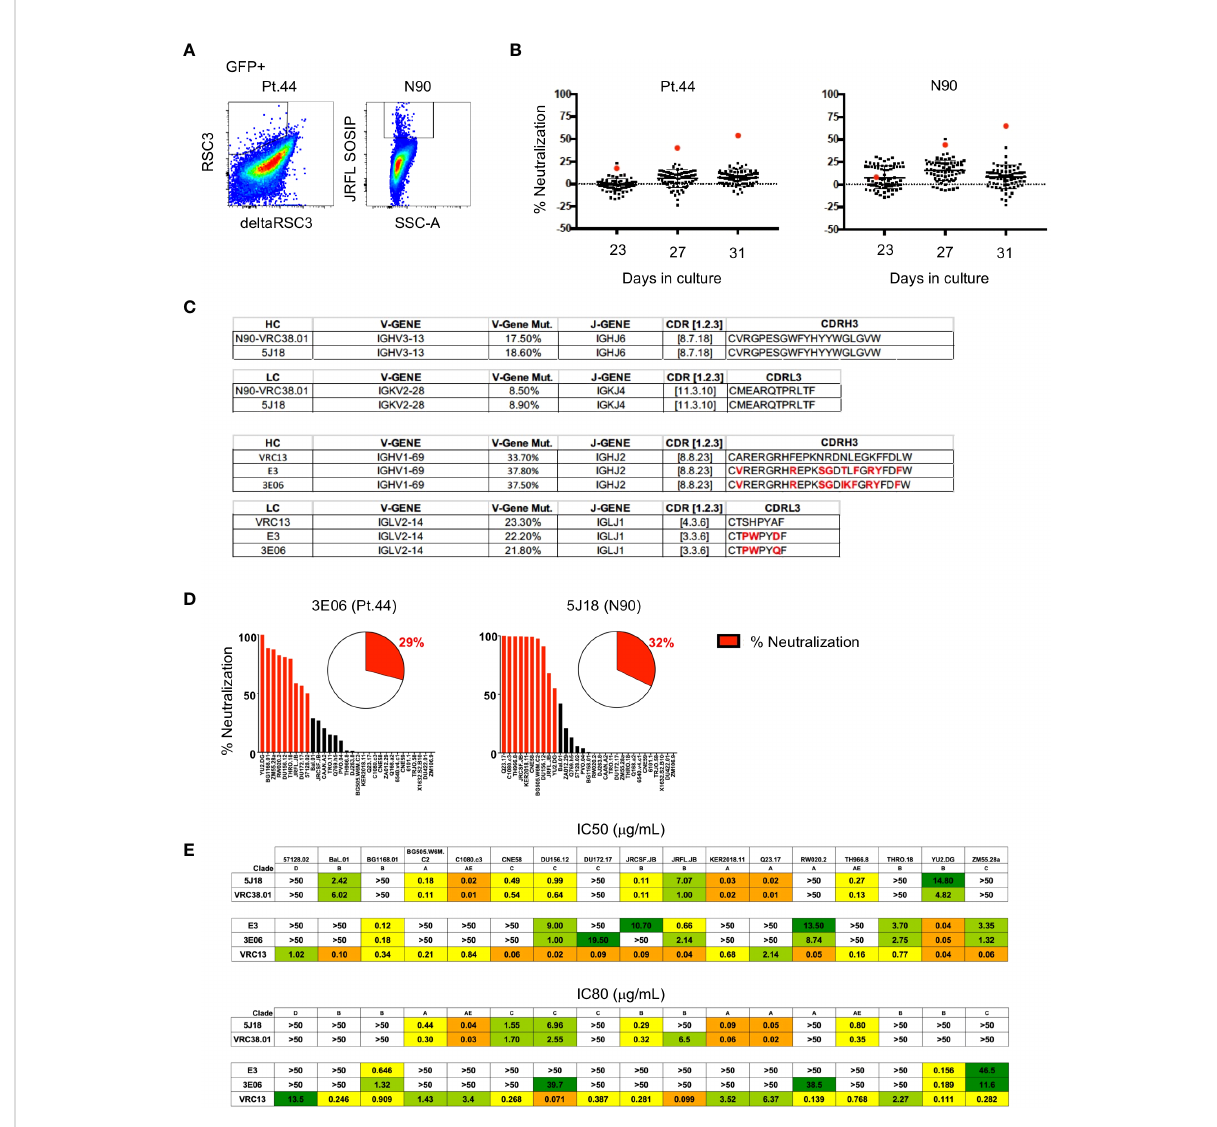
FIGURE 5 Isolation of bNAbs from HIV-1-infected individuals. (A) Flow cytometry plots showing B cell binding to HIV-1-envelope speci fi c probes after B cell transduction. (B) Percent neutralization of B cell culture supernatants against the JRFL pseudovirus following 23, 27 or 31 days of microculture. (C) Immunogenetic characterization of antibodies sequenced from wells identi fi ed as having greater relative neutralization. (D) Single point neutralization assays were performed against a 31-virus panel for the cloned antibodies. (E) IC50 and IC80 values were determined for the three identi fi ed antibodies using a panel of 17